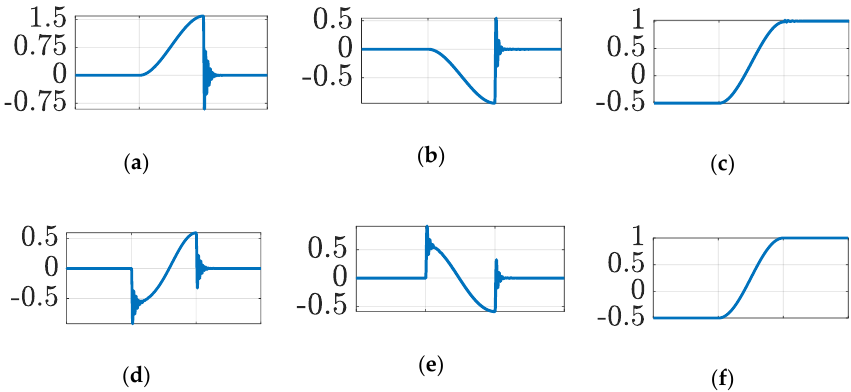
Figure 6. Comparison of True Euler angles during slew, ( a , d ) roll, ( b , e ) pitch, and ( c , f ) yaw. Top row ( a – c ) using Pontryagin derivation in principal frame, bottom row ( d – f ) using Pontryagin derivation in non-principal frame. ( a ) roll using principal frame, y -axis [ − 1,1.5] ( b ) pitch in principal frame, y -axis [ − 4,2], ( c ) yaw using principal frame, y -axis [0,30], ( d ) roll using non-principal, y -axis [ − 1.5 × 10 −3 ,1 × 10 −3 ], ( e ) pitch using non-principal axis, y -axis [ − 3 × 10 −3 , 4 × 10 −3 ], ( f ) yaw using non-principal, y -axis [0,30].